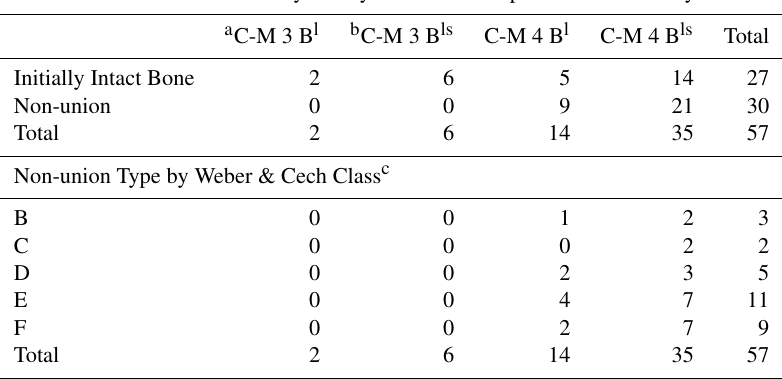
Table 2. Microbiological culture results in the series. Organism Number of cases Polymicrobial 23 Culture negative 6 Monomicrobial 27 Pseudomonas spp.